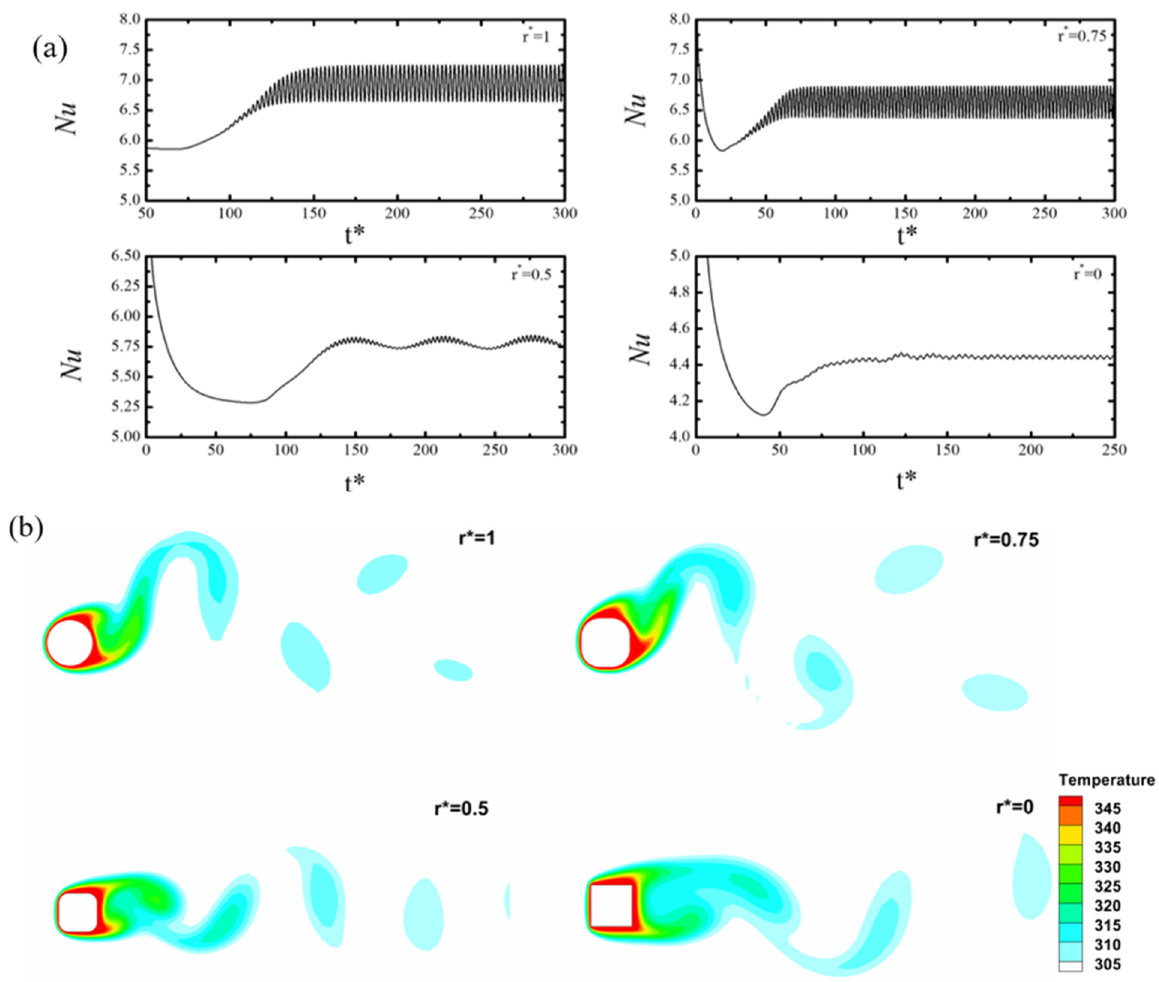
Figure 12. Effect of r * on heat transfer with vortex-induced vibration at Re = 150 and 𝑈𝑟 = 4.92 . ( a ) Time histories of the lift coefficient. ( b ) Temperature contour of the different radius corners .